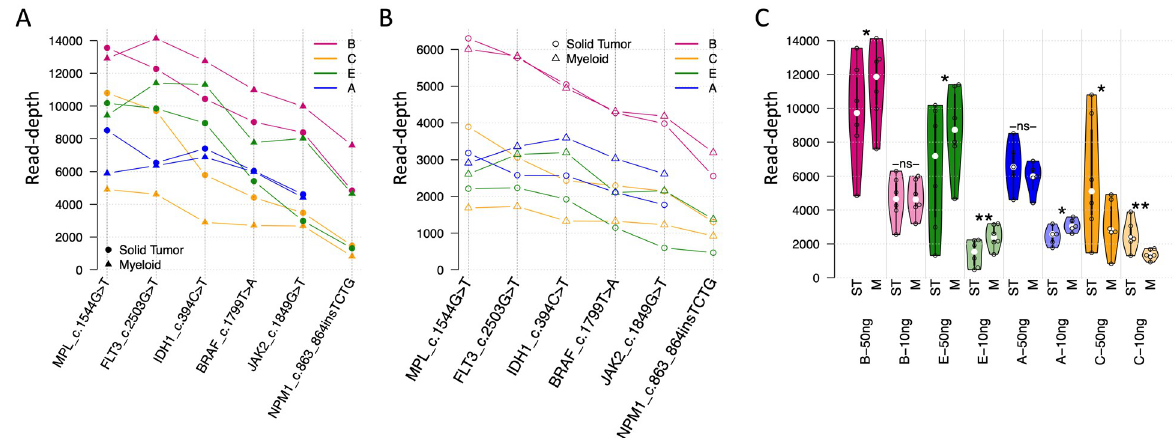
Fig 6. Impact of DNA extraction process on depth of coverage. Solid tumor or ST, reference samples carrying solid tumor mutations that were tested without DNA extraction; myeloid or M, reference samples carrying myeloid mutations that were tested including DNA extraction. A, Coverage depth for the 6 common mutations across the two reference sample sets for 30 ng (assay A and B) or 50 ng (assay C, D, E) DNA input. B, similar analysis for 10 ng input. C, Intra-assay comparison of coverage depth with vs. without DNA extraction process; statistical significance for the distribution mean differences measured by paired t-test (-ns- not significant, � < 0.05, �� < 0.01). Overall, assay C (dark and light yellow violin plots) was the only one that tended to perform worse when DNA extraction was included.